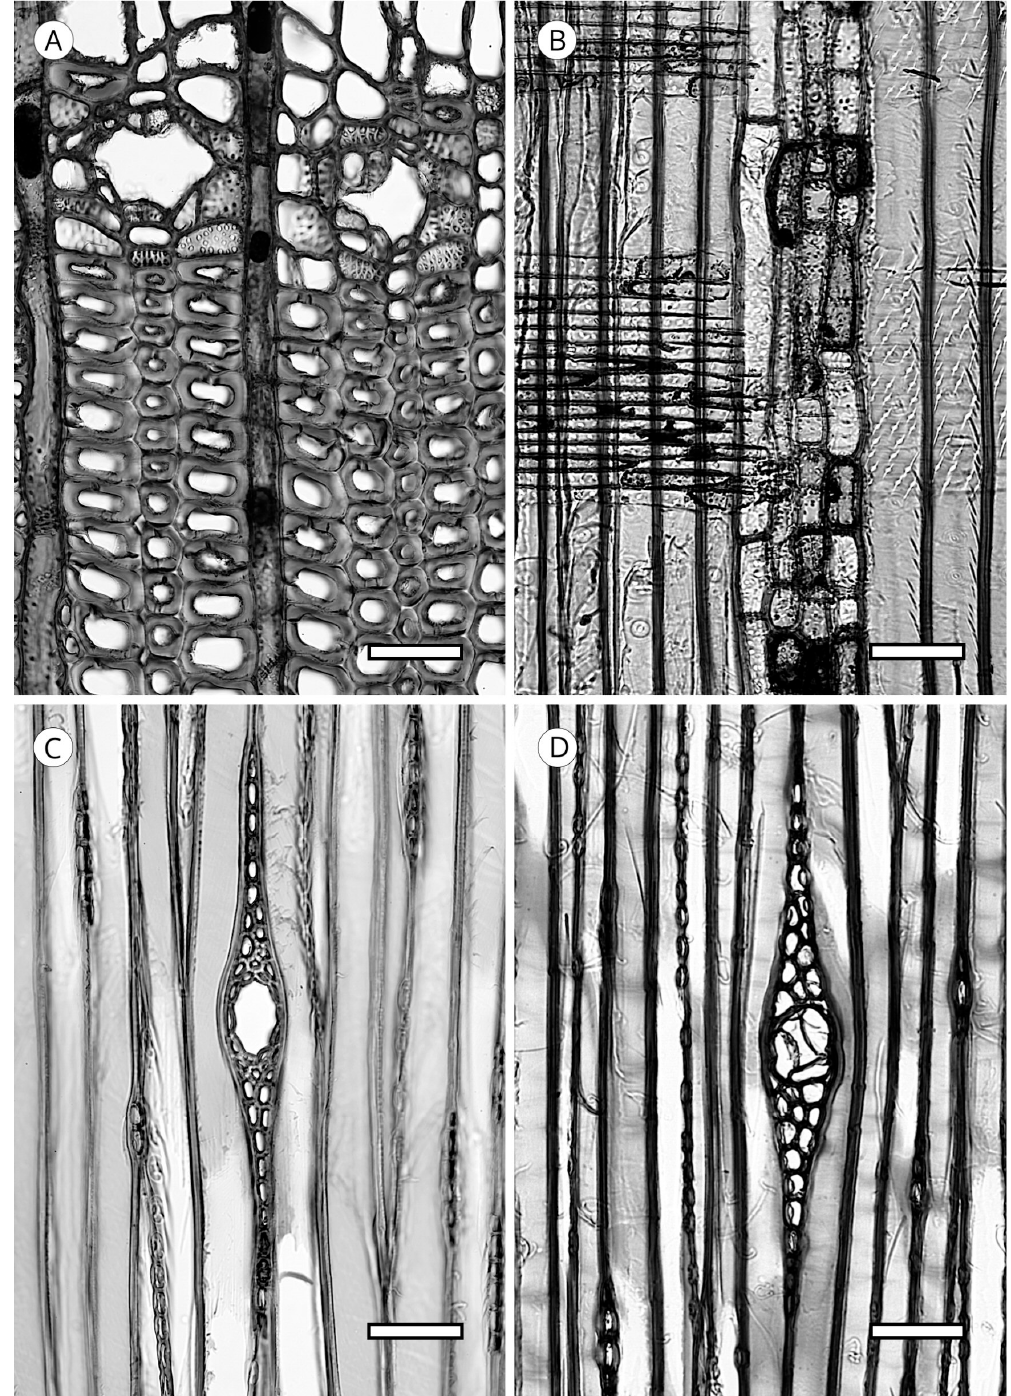
Figure 40. Normal axial and radial resin canals. ( A , B ) Axial resin canals in Keteleeria davidiana (C.E.Bertrand) Beissn.; ( C ) Thick-walled epithelial cells in radial resin canals of Picea glehnii (F.Schmidt) Mast.; ( D ) Thin-walled epithelial cells in radial resin canals of Pinus armandi Franch. Scale bars. ( A – D ) = 50 μ m.